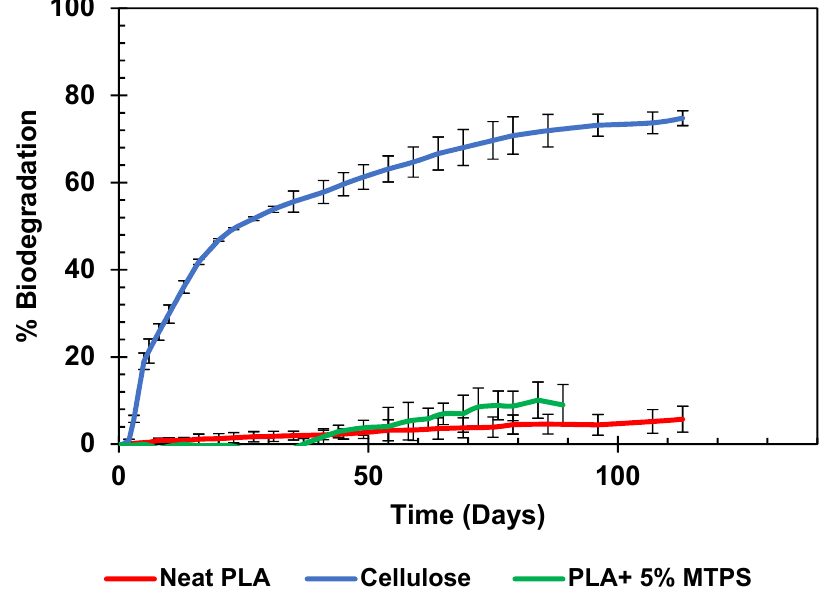
Figure 18. Aqueous biodegradation curves for PLA and PLA + 5% MTPS.